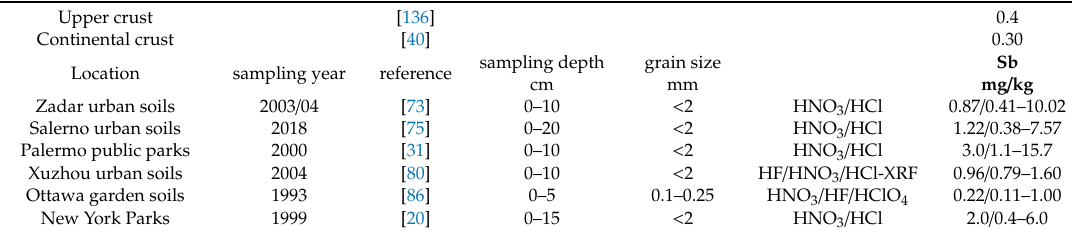
Table A17. Antimony in urban